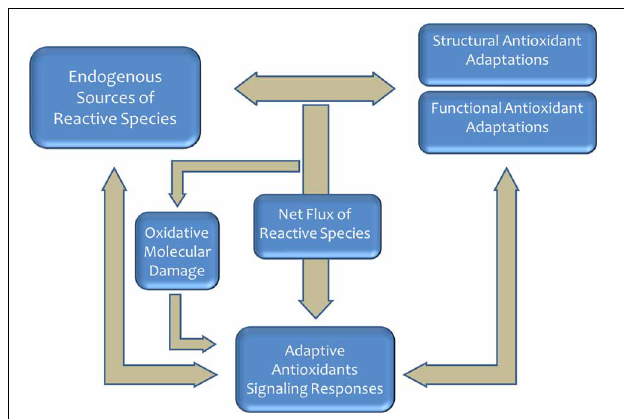
FIGURE 1 | Aerobic life produces reactive species that required the emergence and selection of antioxidant defense systems. Redox state is an important selective pressure faced by most organisms, and a myriad of mechanisms have evolved to regulate and adjust this process. In homeostatic conditions, the sytem play a key role in the aging process and the determination of the